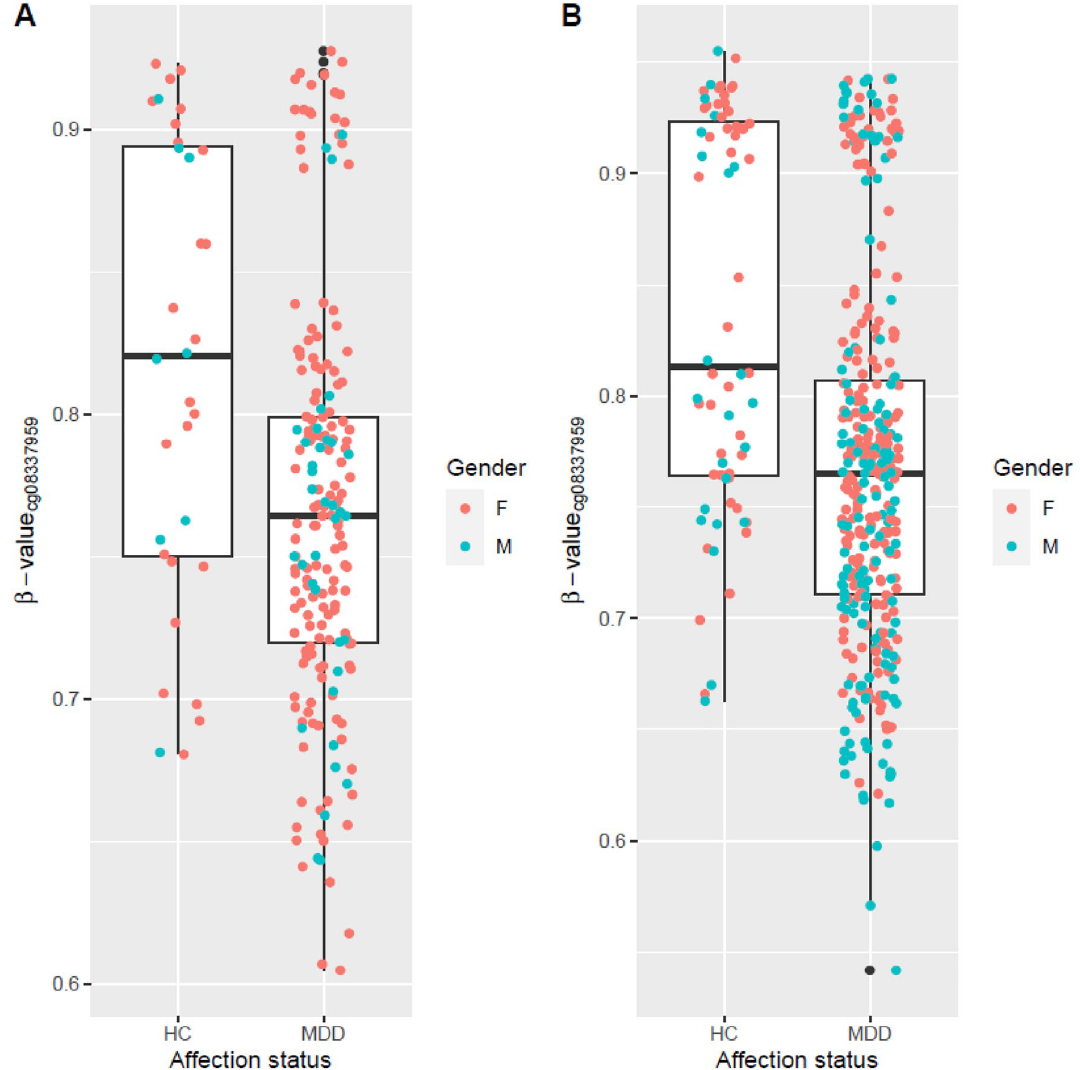
Figure 2. Association of cg08337959 annotated to TNNT3 with MDD case–control status in ( A ) cohort 1, ( B ) cohort 2.